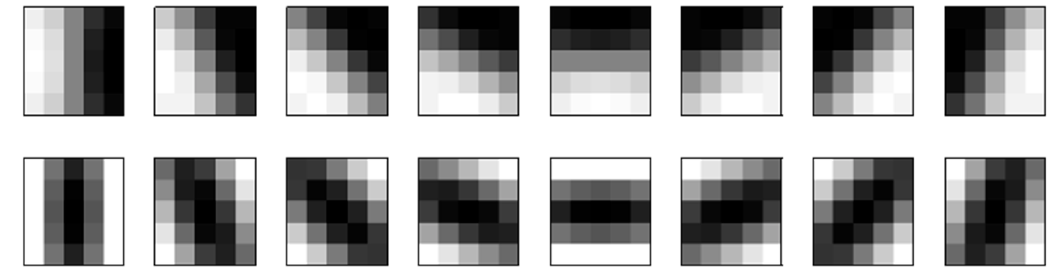
Figure 4. First-order and second-order Gaussian derivative filters for facial feature descriptions. The figures in the first row are first-order Gaussian derivative filters, and those in the second row are second-order Gaussian derivative filters.